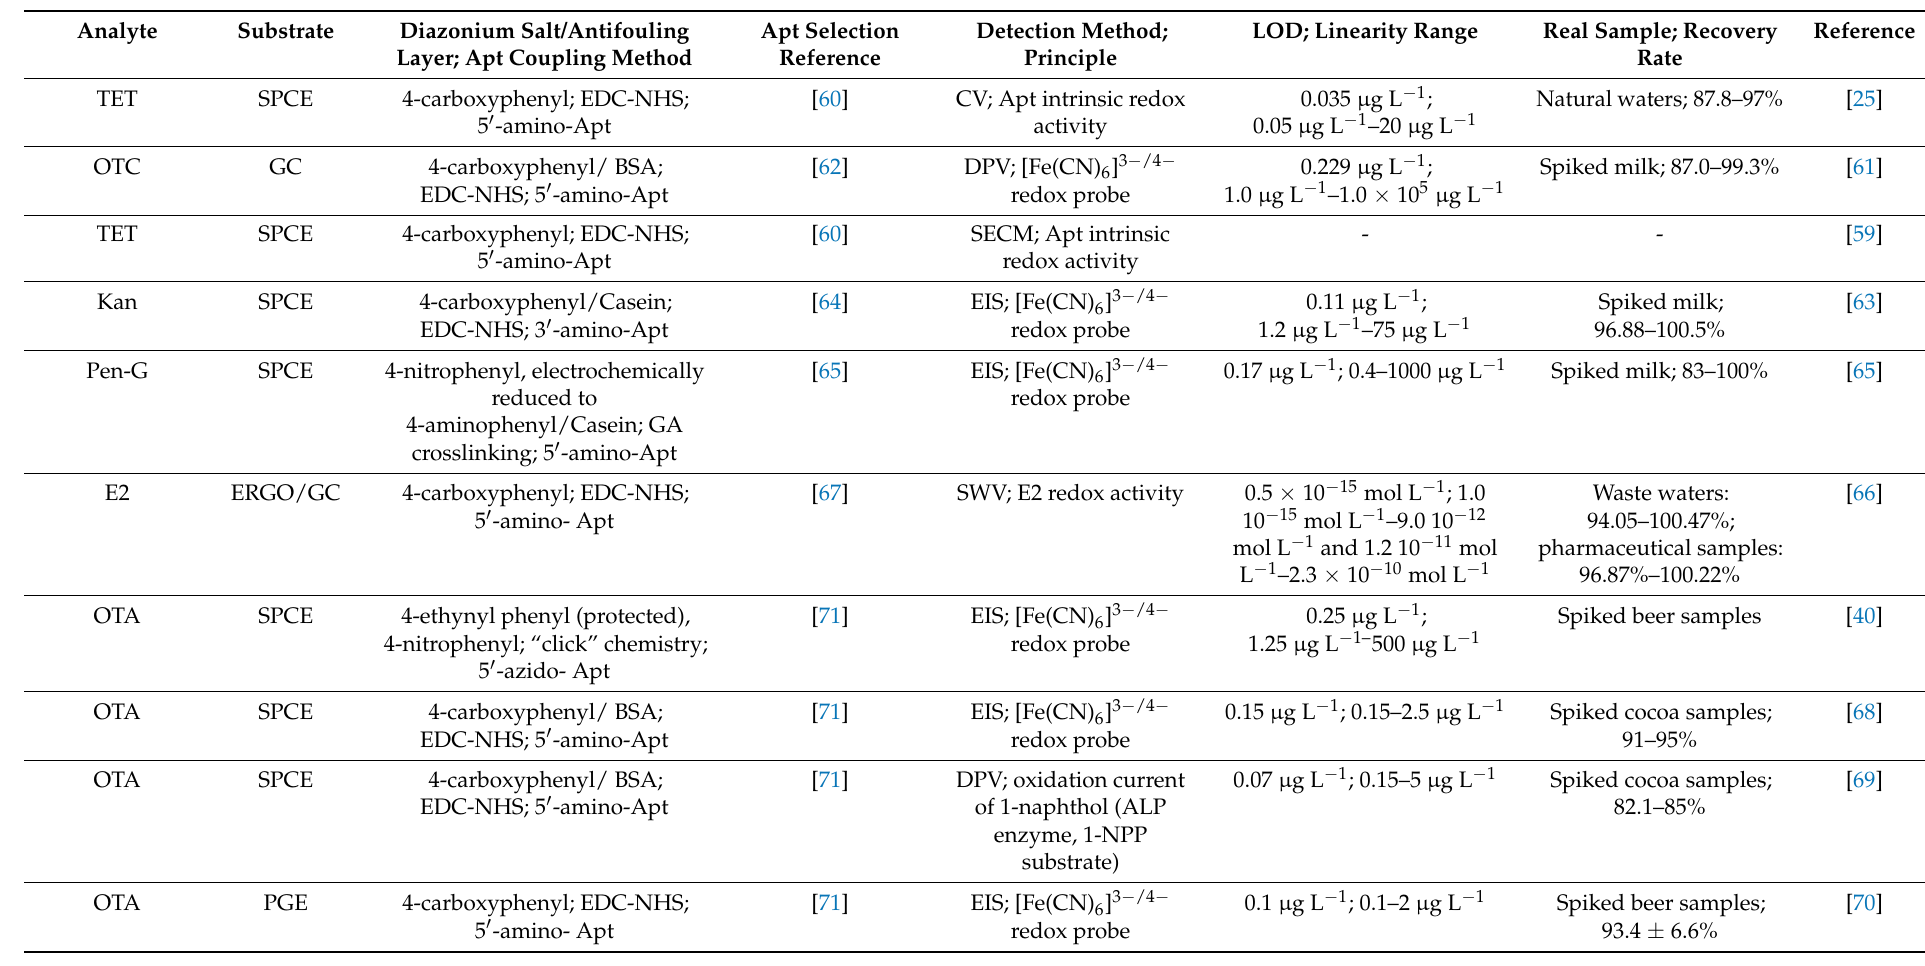
Table 2. Analytical performance of electrochemical aptasensors for food contaminants developed using diazonium